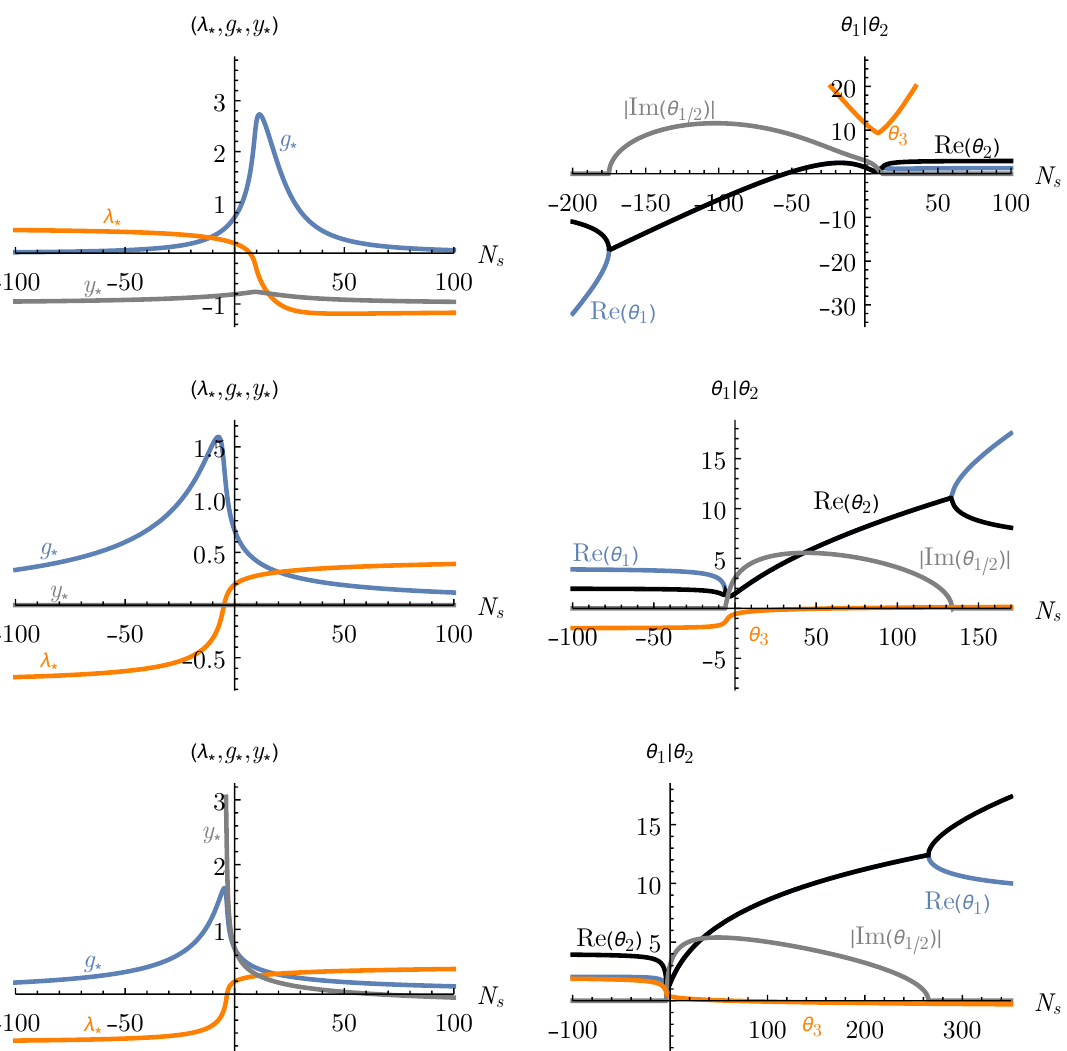
Figure 5 . Illustration of the (cid:12)xed point structure resulting from the full system of beta func- tions (3.13) as a function of N s . The characteristics of the NGFP (cid:0) , NGFP 0 , and NGFP + are shown in the (cid:12)rst, second, and third row, respectively.